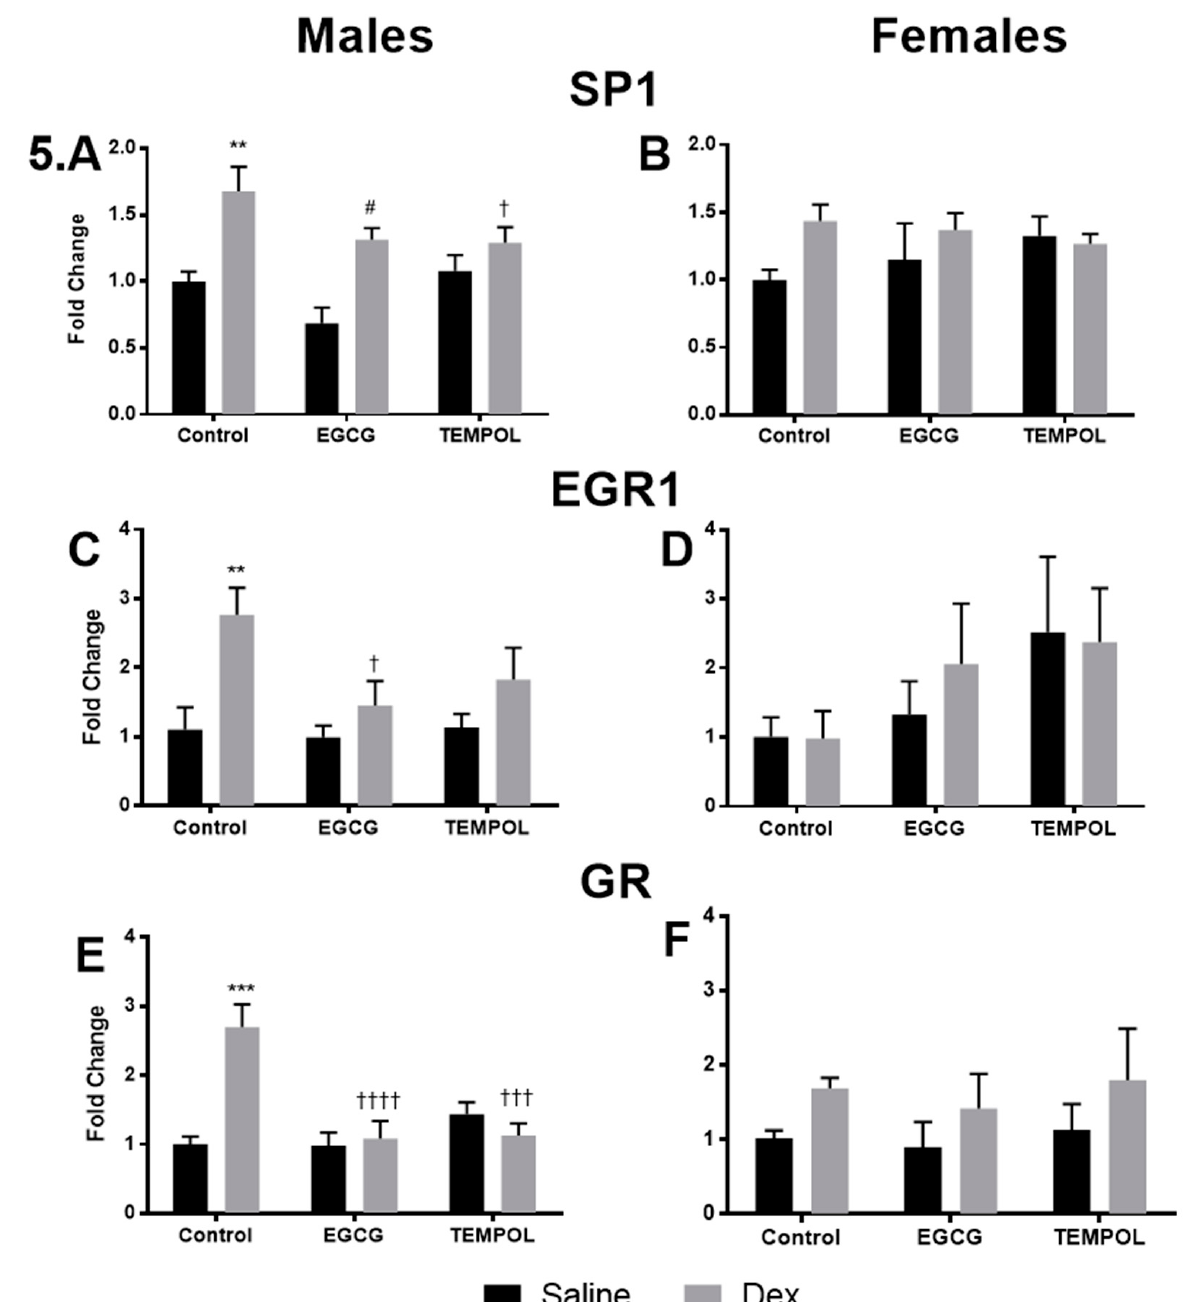
Figure 5. Relative mRNA expression of transcription factors involved in catecholamine biosynthetic enzyme expression (2 − ∆∆ Ct ). qPCR gene expression of transcription factors specificity protein 1 ( SP1 ) ( A , B ), early growth response 1 ( EGR1 ) ( C , D ), and glucocorticoid receptor ( GR ) ( E , F ) for males and females, respectively. Saline and Dex control have been published previously and have been provided for reference [7]. Results from a Two-way ANOVA (Fisher’s LSD test) are shown, significance is depicted as † p ≤ 0.05, ** p ≤ 0.01, ***/††† p ≤ 0.001. Comparison to the Control-Saline group is represented with the symbol (*), (†) for the Control-Dex offspring and (#) is relative to the EGCG-Saline group. n = 4–6 per group. Data are presented as mean ± SEM. Significant interactions between maternal injection and antioxidant administration were found for GR males.